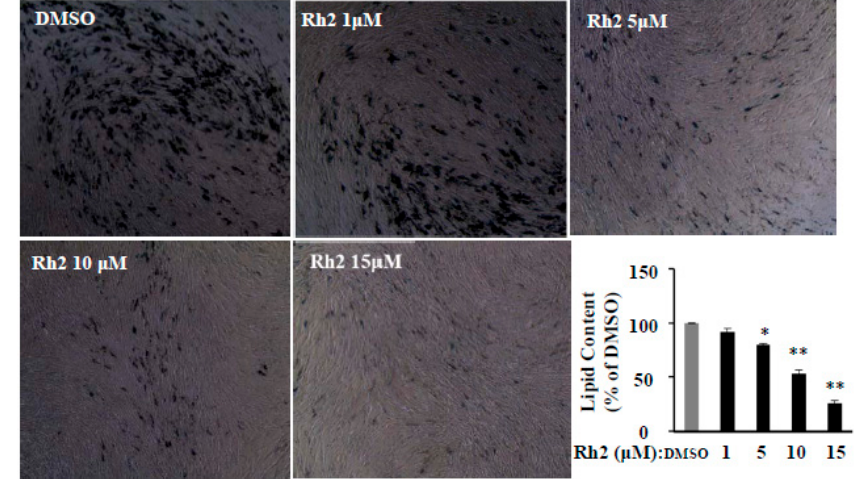
Figure 5. Ginsenoside Rh2 dose-dependently reverses lipid accumulation, protein expressions of differentiation markers in human primary preadipocytes (HPPs). The cells stained with Oil-red O on day 15 were dissolved in isopropanol, and fat accumulation was measured by absorbance using Synergy H1 hybrid reader at 490 nm. Oil-Red O representative images of lipid accumulation and the average bar graph are shown (40 × magnification). Values are means ± SE, n = 4. A set of representative images and bar graphs are shown. * p < 0.05, ** p < 0.01 vs. DMSO.